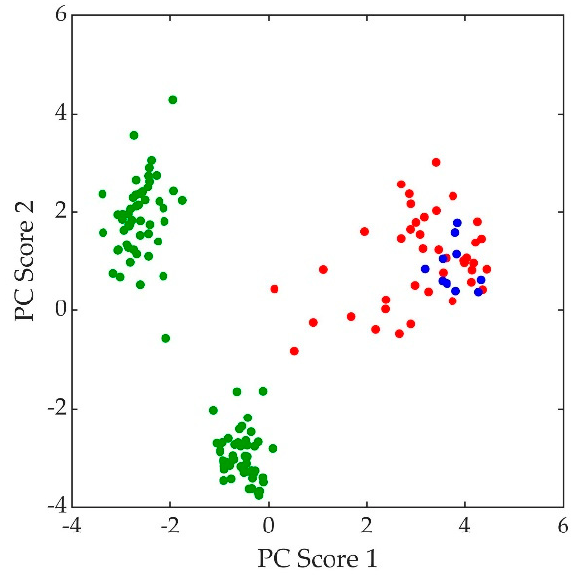
Figure 8. Principal component (PC) scores of C. neoformans strains: H99 (red), H99 ghost (blue), and lac1 Δ (green).